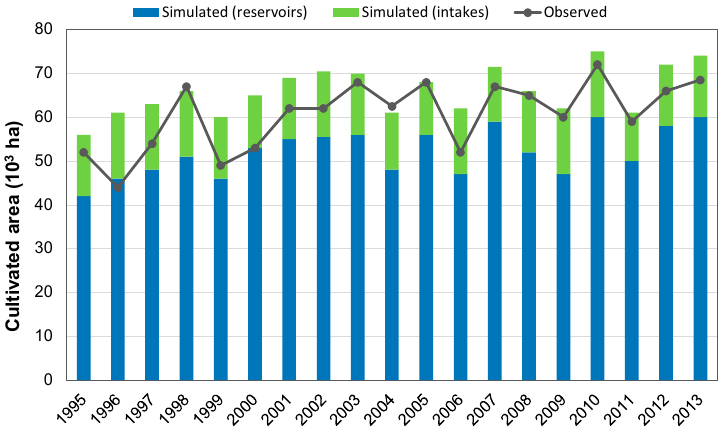
Figure 7. Comparison between the observed (black line) and simulated cultivated area related to reservoirs (blue bars) and direct water intakes (green bars) for the Cuareim/Quaraí watershed.